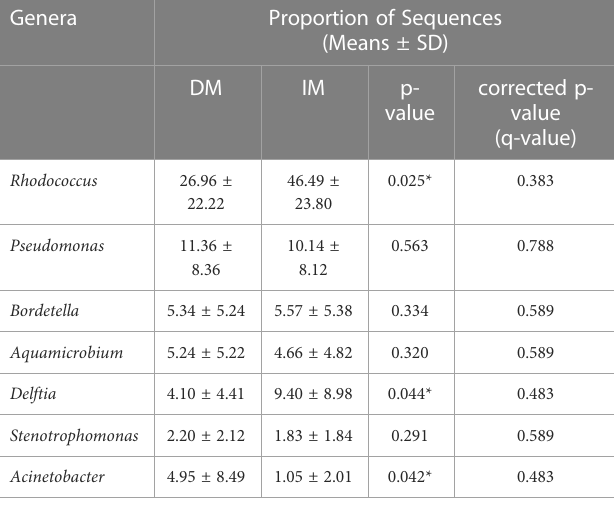
TABLE 3 The relative abundances at the genus level and statistical signi fi cance between the DM and IM groups by FDR. Genera Proportion of Sequences (Means ± SD) DM IM p- corrected p- value value (q-value)